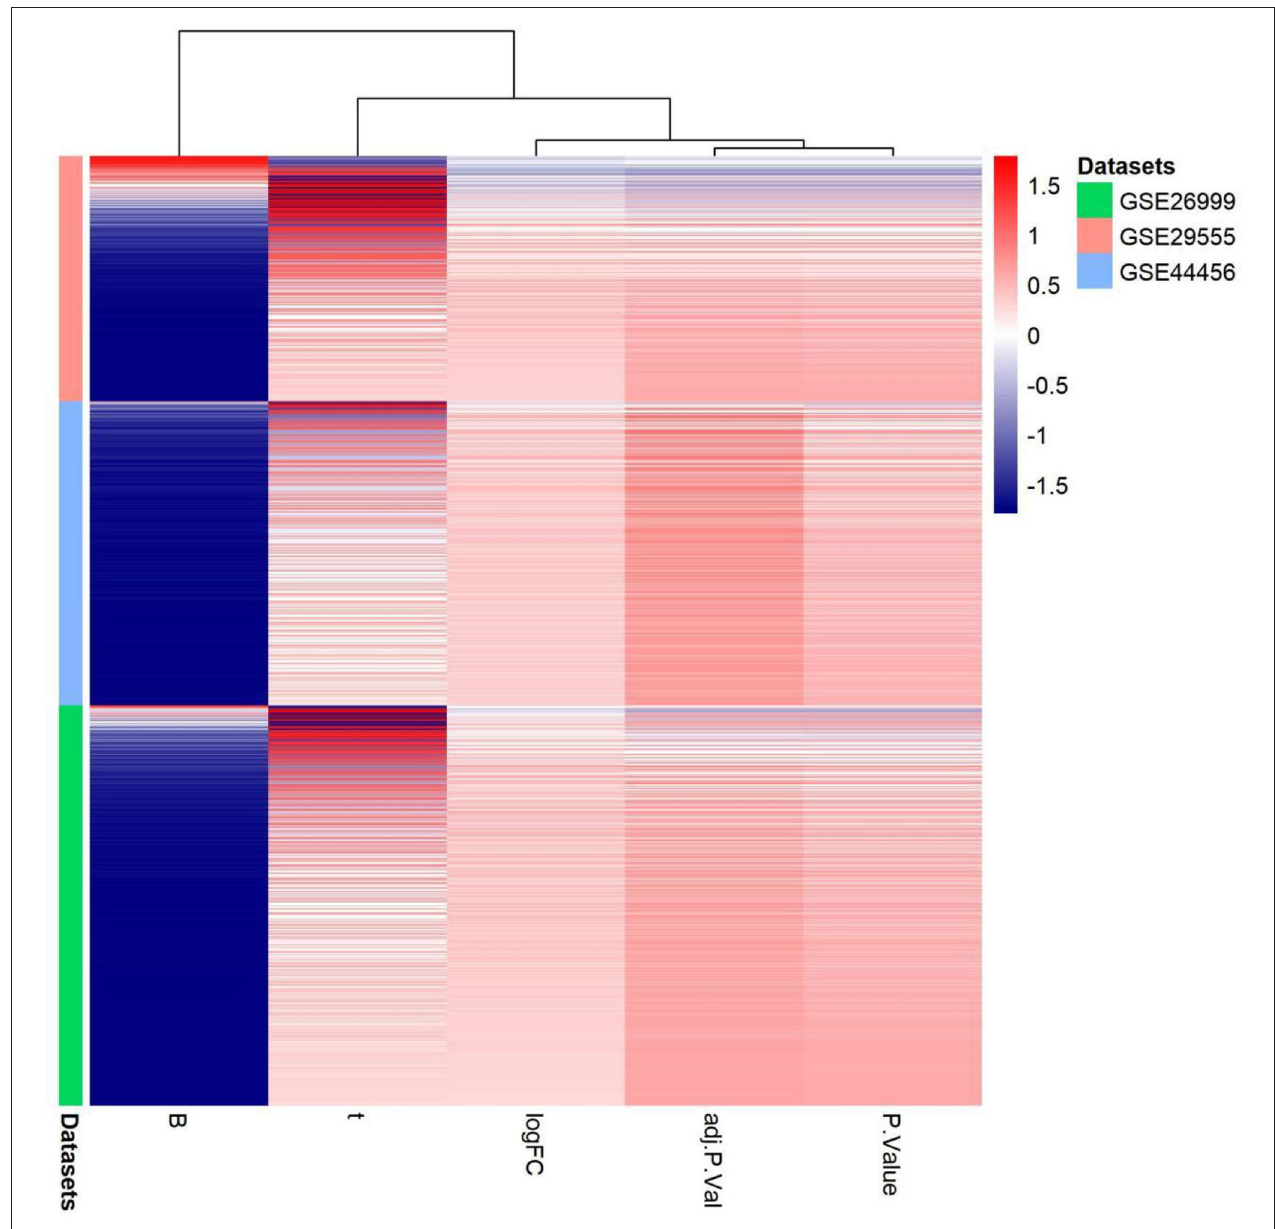
FIGURE 8 | Gene expression patterns in the three gene expression datasets: GSE29555, GSE44456, and GSE62699. Upregulation of genes is marked in red; downregulation of genes is marked in